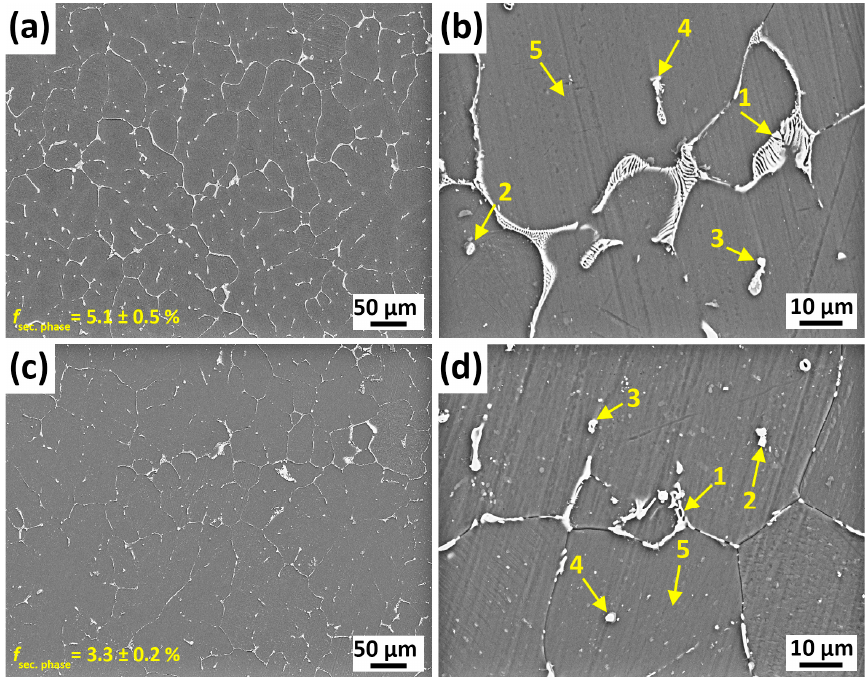
Figure 4. SEM micrographs of ( a , b ) as-cast and ( c , d ) homogenized alloys. Table 2. EDS results of the points in Figure 4.